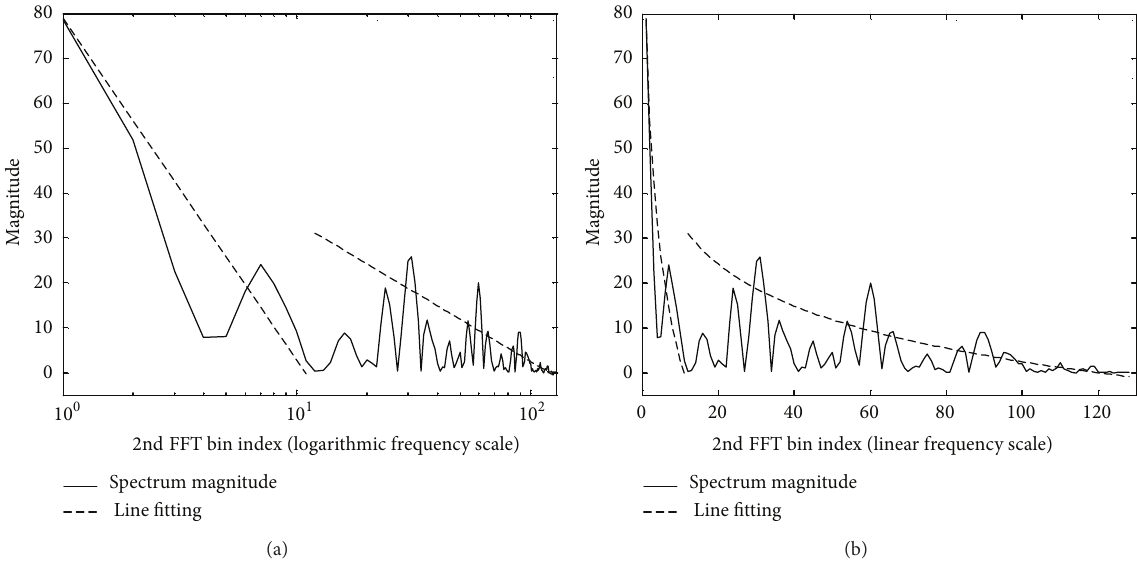
Figure 6: Result obtained from fitting the line to the spectrum magnitude: (a) line fitting to the magnitude in the linear frequency scale and (b) line fitting to the magnitude in dB in the logarithmic frequency